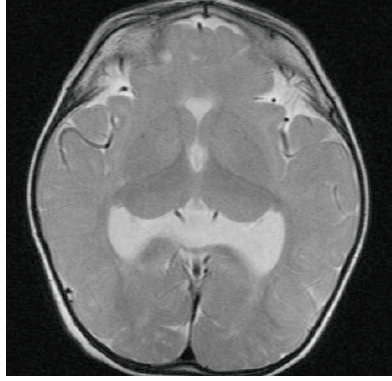
Fig. 1. Sagittal T1-weighted midline MR image. Fig. 2. Axial T2-weighted image at level of